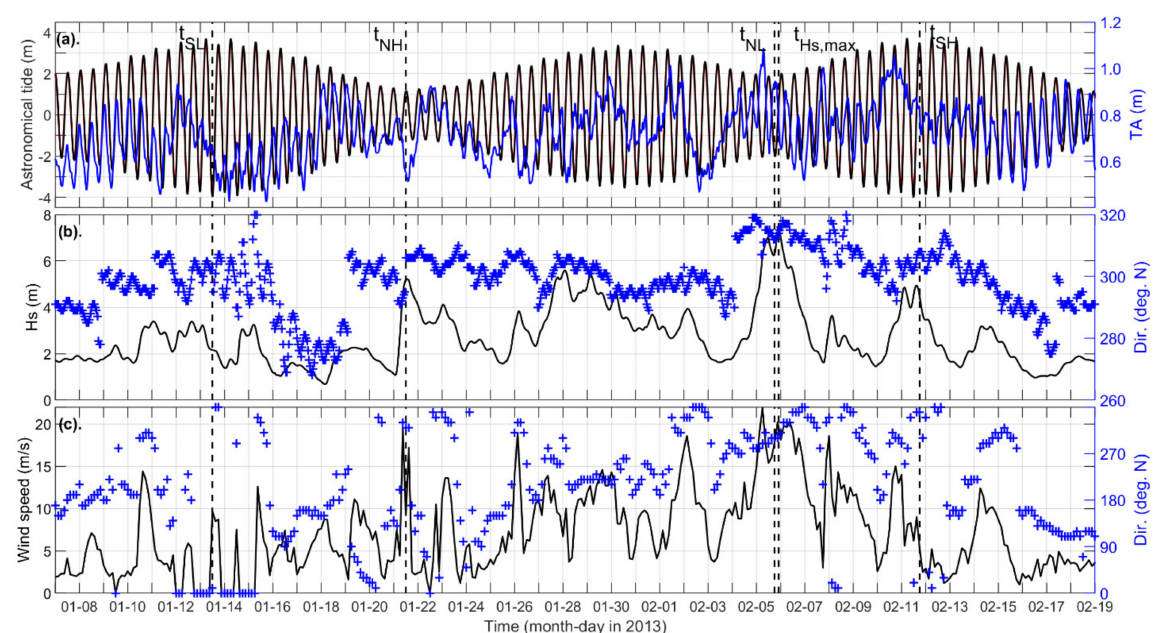
Figure 2. Data used for the numerical simulations. ( a ) Predicted astronomical tide at A G1 (red line) and B G1 (black line). Note that the red line is not visible because there was only a 10 min phase shift between the time series at A G1 and B G1 . The blue line is the derived tidal anomaly (TA) at S3 (Figure 1d). ( b ) Significant wave height (black line) and direction (blue crosses) at W1 (Figure 1b) from the WW3 model. ( c ) Measured wind speed (black line) and direction (blue crosses) at BR (Figure